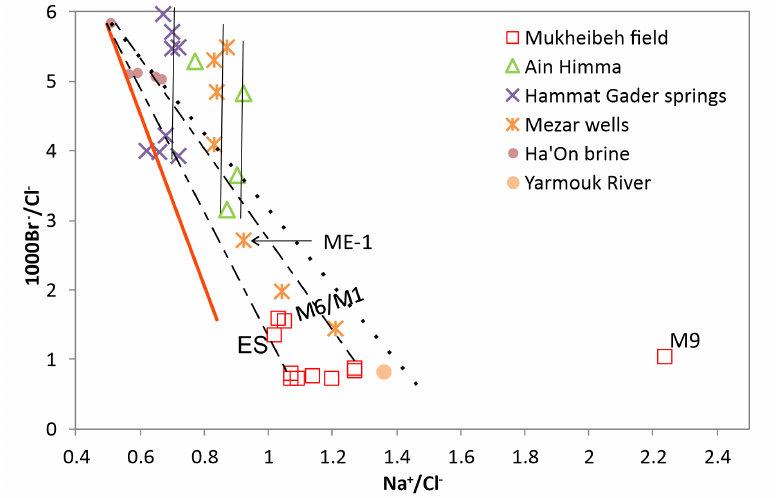
Figure 6. Cross plots of Na + /Cl − vs. 1000 · Br − /Cl − of Ha’On brine analyses in the years 1961–2004 and of evaporated seawater (red line) [59,60]. Present-day Ha’On brine is a dilution product of the original Ha’On brine and basaltic-rock groundwater with Na + /Cl − > 1 (dashed line). The intersection of the dilution line with the trend line of the evaporated seawater approach: the values of Na + /Cl − and 1000 Br − /Cl − of the original Tortonian Ha’On brine are 0.43 and 5.9, which significantly deviate from the ones measured in the years of 1961 and 2004 (Table 1). The vertical lines indicate leaching of Br − from B2 . The solid line represents mixing of Ha’On brine and basaltic-rock water in the Mukheibeh field. Code names are explained in Table